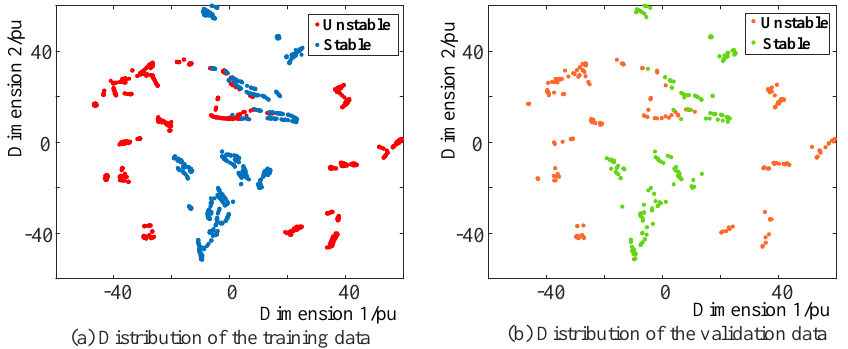
Figure 7. Distributions of training and validation data generated from the IEEE 39-bus system.